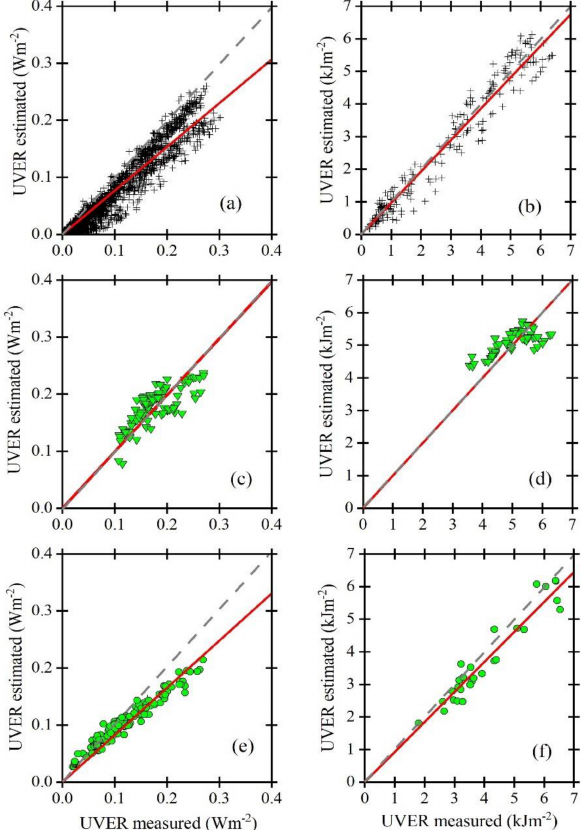
Figure 7. Comparison of the UVER estimated and measured for ( left ) hourly and ( right ) daily data in Santiago using the following models: General ( a , b ), Summer + Partially clear ( c , d ), and Spring + Partially clear ( e , f ). The dashed grey line indicates the 1:1 line. Red lines indicate the fitting using the least-squares regression